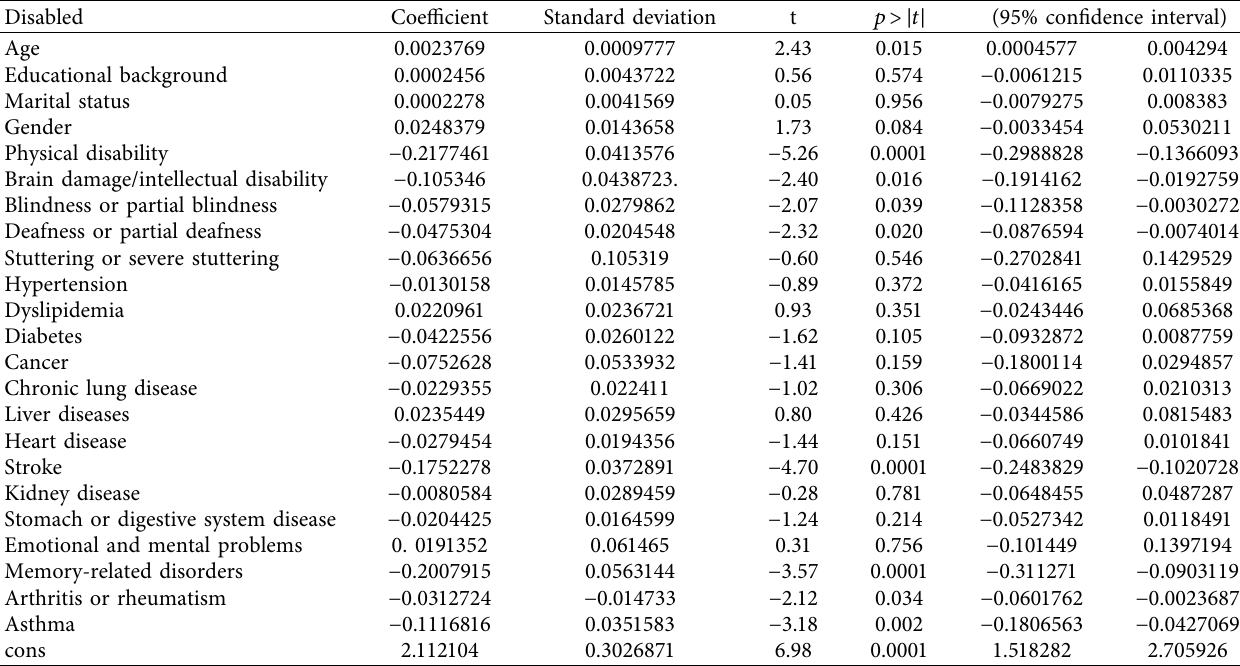
Table 5: Multiple regression results for the individual variables of the